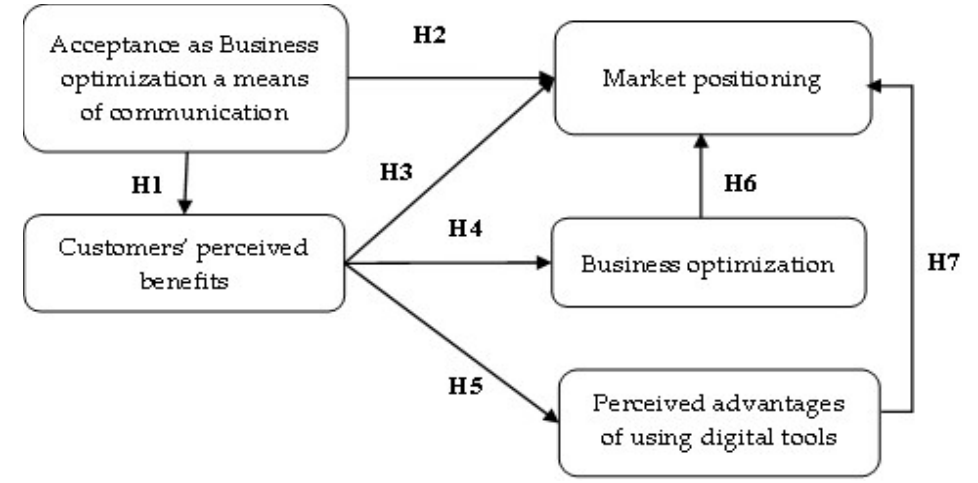
Figure 1. Research model proposed in this study to analyse the use of digital marketing by small and medium-sized enterprises. Medium-Sized